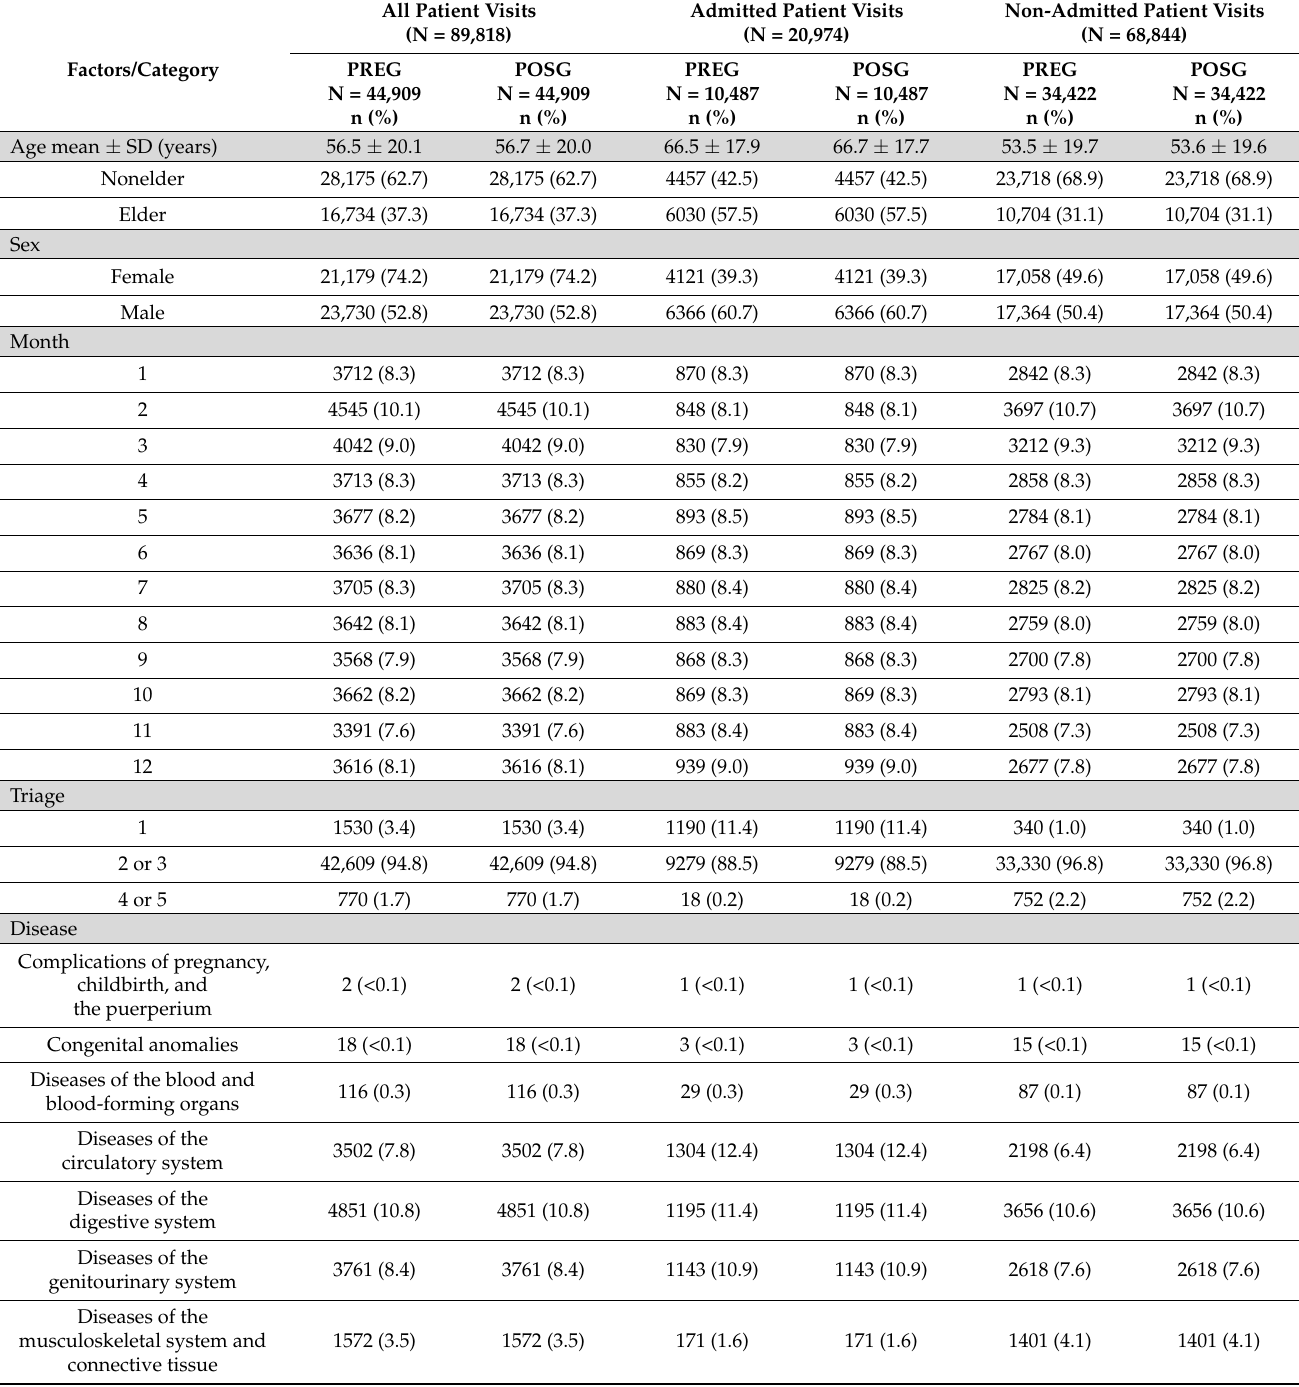
Table 1. Comparison of demographic and medical information for ED patient visits between the PREG and